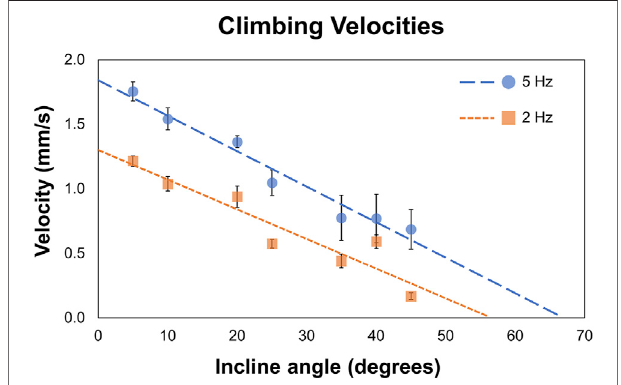
FIGURE 3 | Climbing velocities. MANiACs climbing different inclines, from 5 ° to 45 ° , is shown at 2 and 5 Hz. Projections suggest that at 2 and 5 Hz the stall angle are approximately 55 ° and 66 ° ,